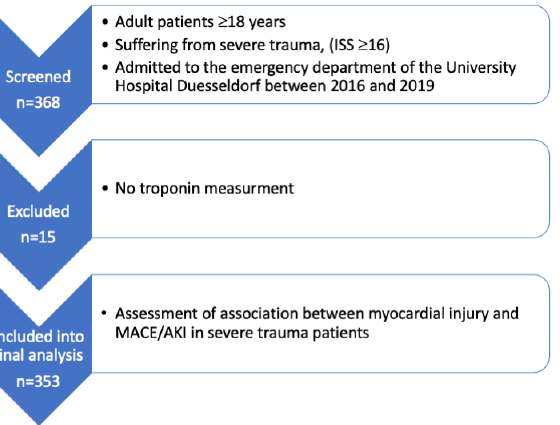
Figure 1. Study flow chart showing the selection process of the study. ISS = Injury Severity Score; MACE = major adverse cardiac events; AKI = acute kidney injury.